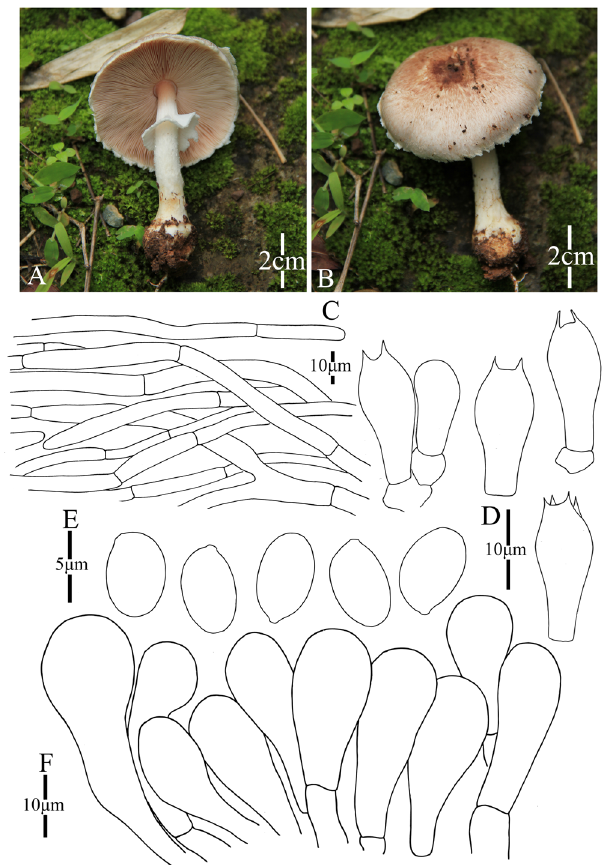
Figure 20. Morphology of Agaricus patris ( A , B ): Basidiome in field ( ZRL2014134 ), ( C ): Pileipellis hyphae, ( D ): Basidia, ( E ): Basidiospores, and ( F ):